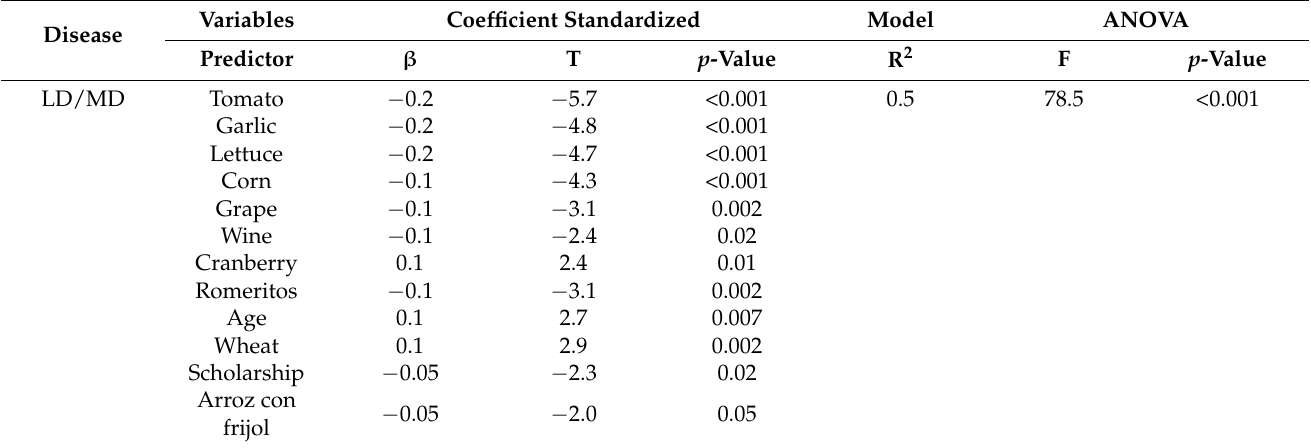
Table 5. Regression analyses of diseases and